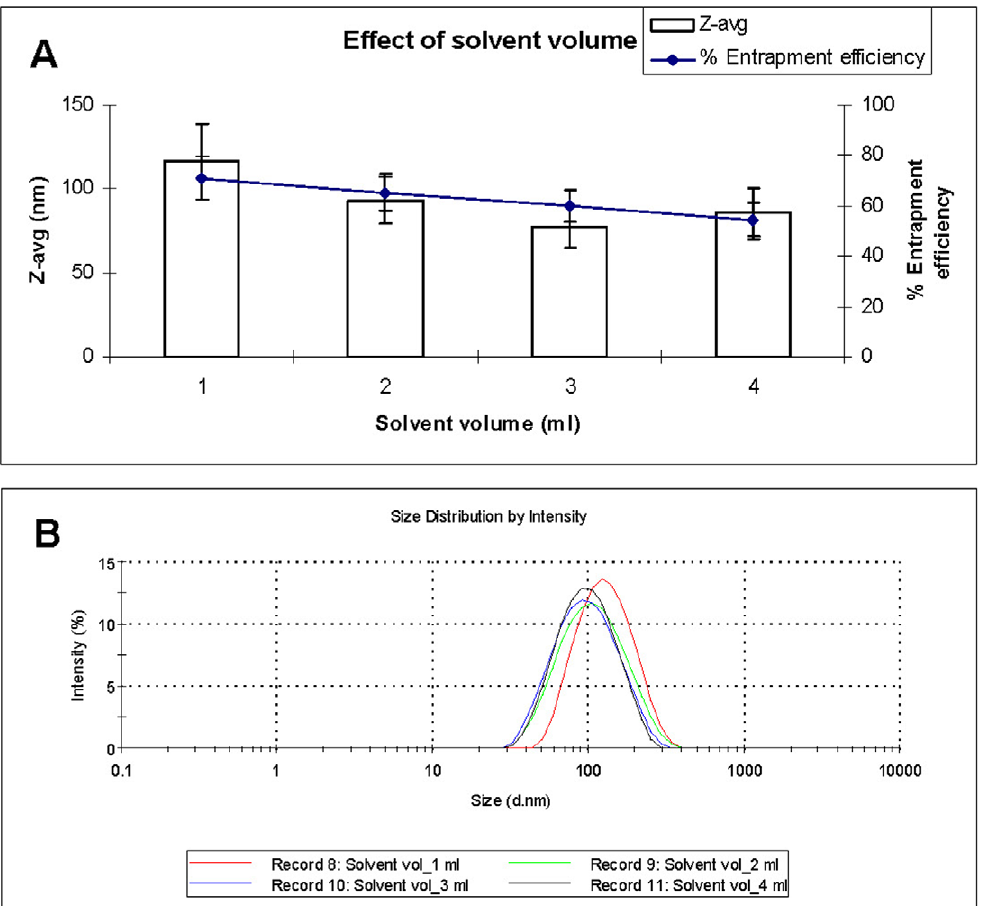
Figure 3. The effect of solvent (DMSO) volume on particle size, entrapment efficiency (A) and particle size distribution (B). For all the preparations, PDI is 0.1 6 0.01.